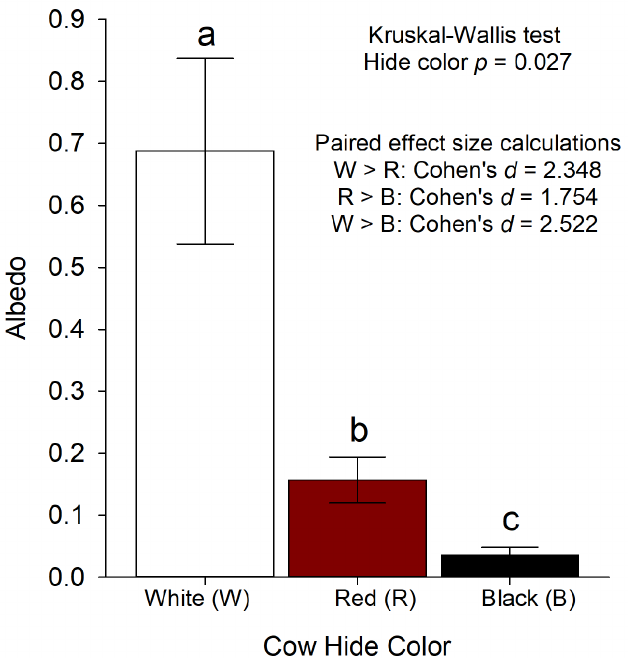
Figure 4. Winter albedo values for white, red, and black cows. Albedo values derived from pixel analyses with snow albedo as a reference. Data were transformed with an arcsine transformation and then analyzed with a non-parametric Kruskal–Wallis test with hide color as the fixed effect. Cohen’s d effect sizes were calculated to understand the magnitude of differences based on the defined alternative hypotheses (HA) for each paired comparison; specifically, HA1: white cow albedo > red cow albedo, HA2: red cow albedo > black cow albedo, and HA3: white cow albedo > black cow albedo. Significant statistical differences were based on α = 0.05 (and indicated by different letters; ( a – c )). Cattle were red, white, and black Bos taurus cows free roaming on rangeland west of